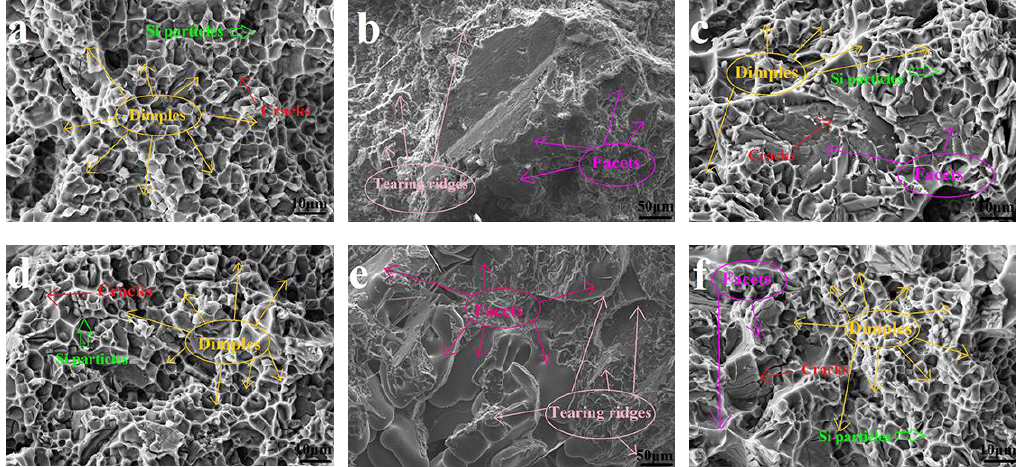
Figure 8. Fracture surface of the base alloy and the 0.6 wt% Zn modified alloy in three types of ageing processes at peak ageing: ( a ) base alloy — 100 °C × 7 h, ( b ) base alloy — 180 °C × 7 h, ( c ) base alloy — 100 °C × 3 h + 180 °C × 9 h, ( d ) 0.6 wt% Zn modified alloy — 100 °C × 5 h, ( e ) 0.6 wt% Zn modified alloy — 180 °C × 5 h, ( f ) 0.6 wt% Zn modified alloy — 100 °C × 3 h + 180 °C × 4 h.